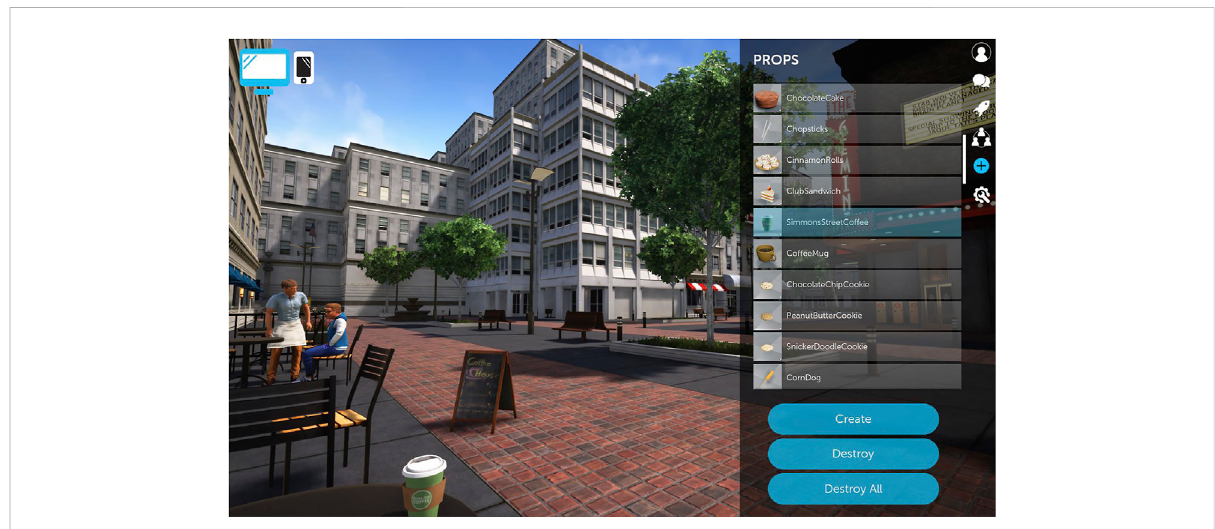
FIGURE 2 The LIVR open world and additional prop features were designed to facilitate dynamic